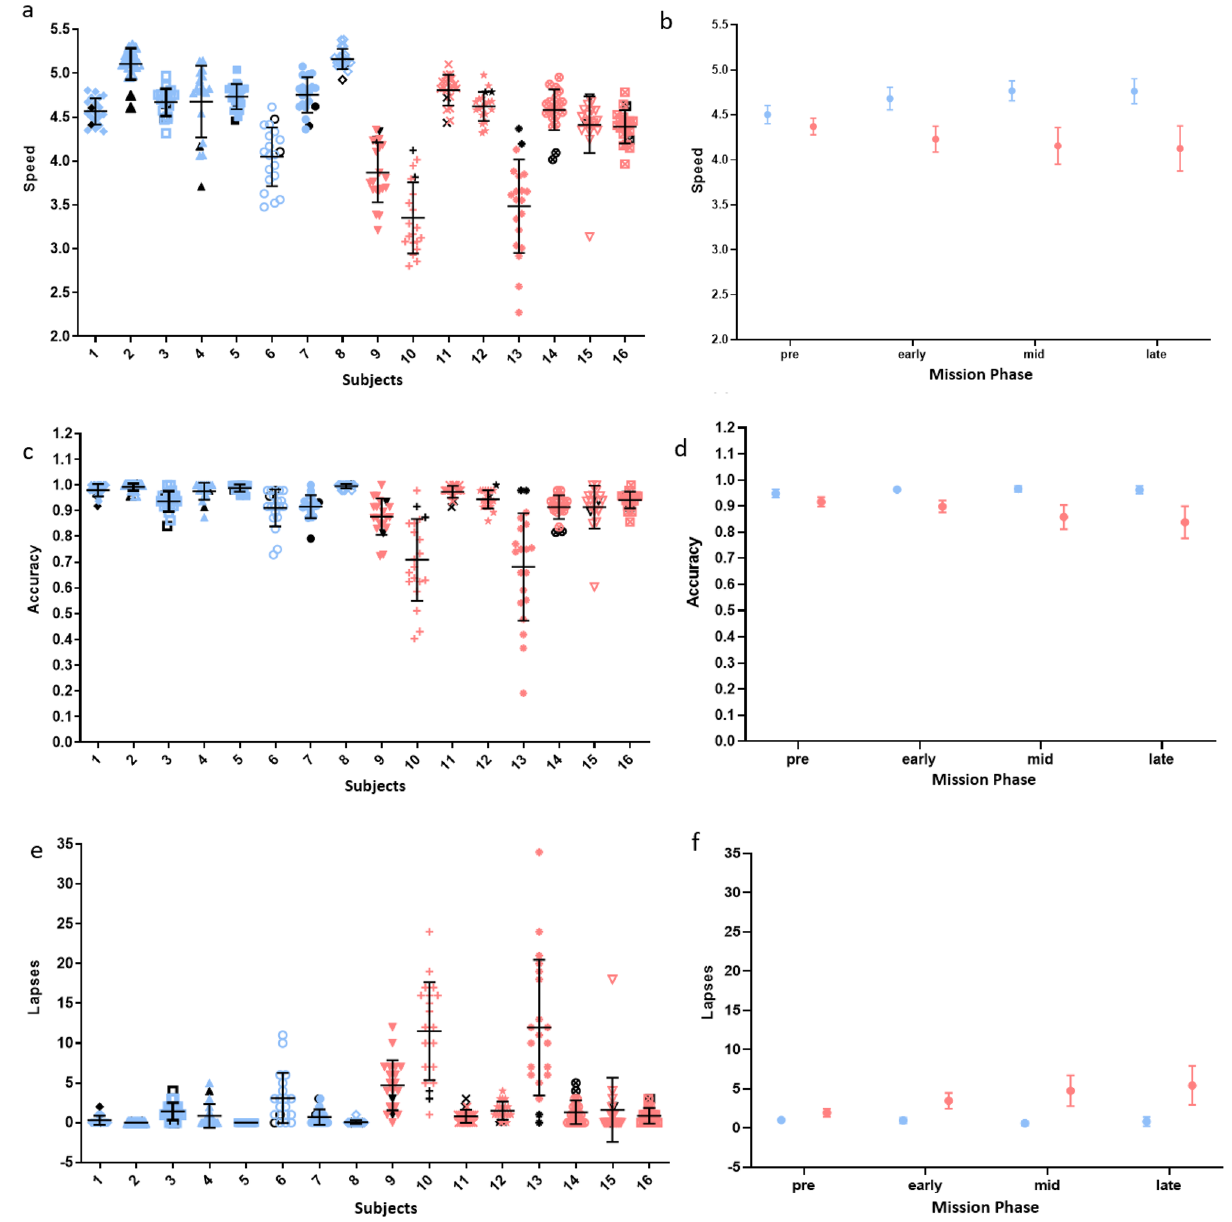
standard diet subjects, and fewer attention lapses compared to standard diet subjects. In ( a,c,e ) each vertical set of samples represents one individual on the enhanced diet (blue) or the standard diet (red). Black symbols denote individual pre-mission average. In ( b,d,f ) plots represent the mean ± SE of all subjects on the enhanced diet (blue) or the standard diet (red) during different phases of the mission. More information is available in SI Appendix, Table